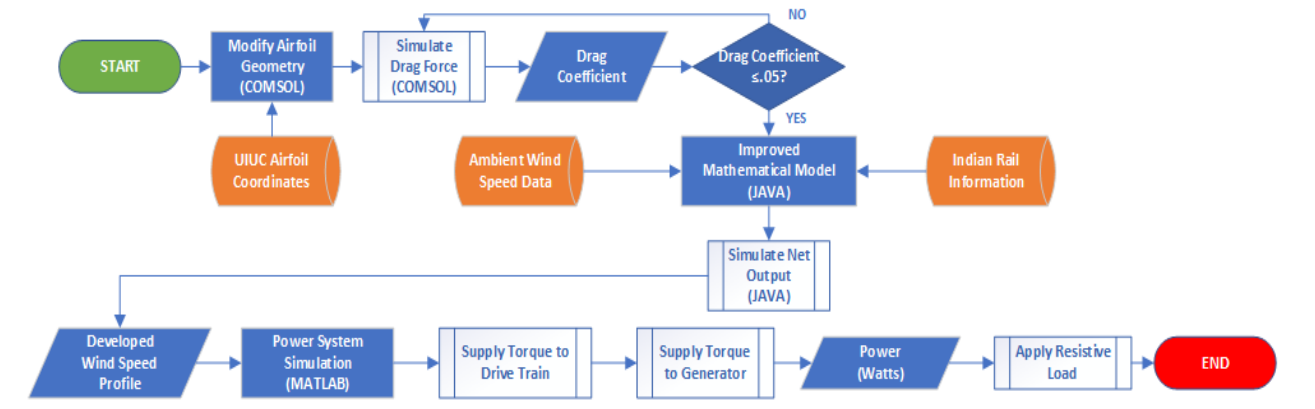
Figure 4. Improved modeling process for wind turbines on trains.